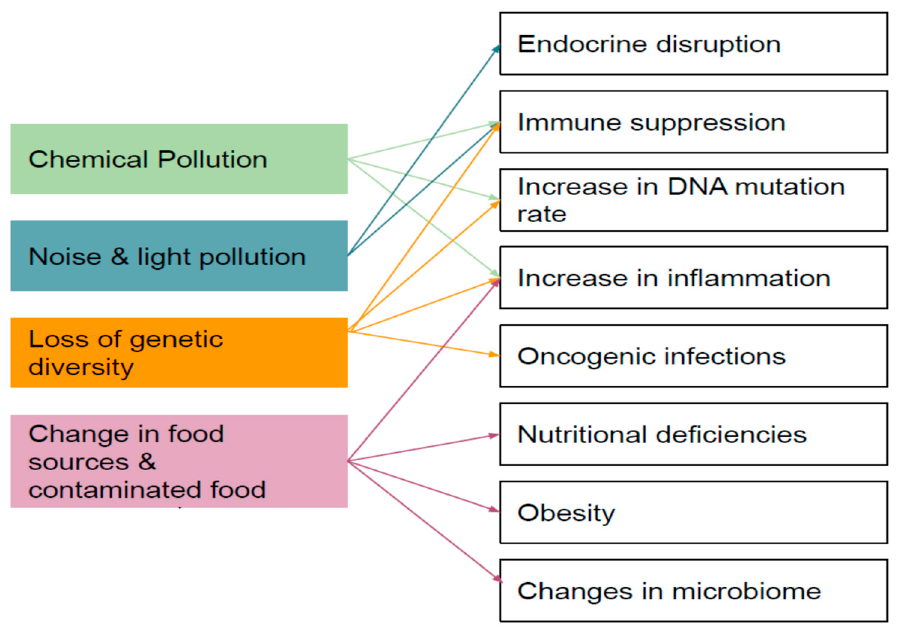
Figure 3. Pathways from effects caused by human activity that may promote disease in wild animals [33].